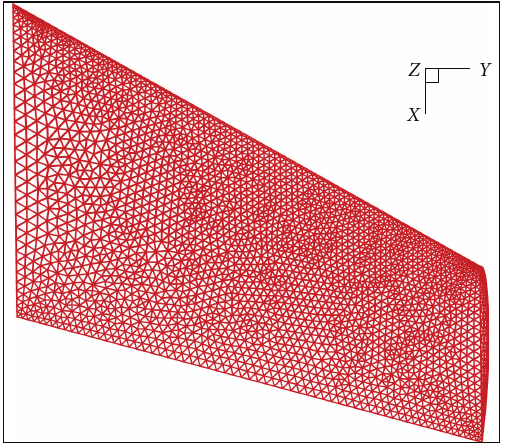
Figure 2: Initial Mach contours for RAE2822 airfoil at M ∞ = 0 . 734 and α = 2 . 79 ◦ .